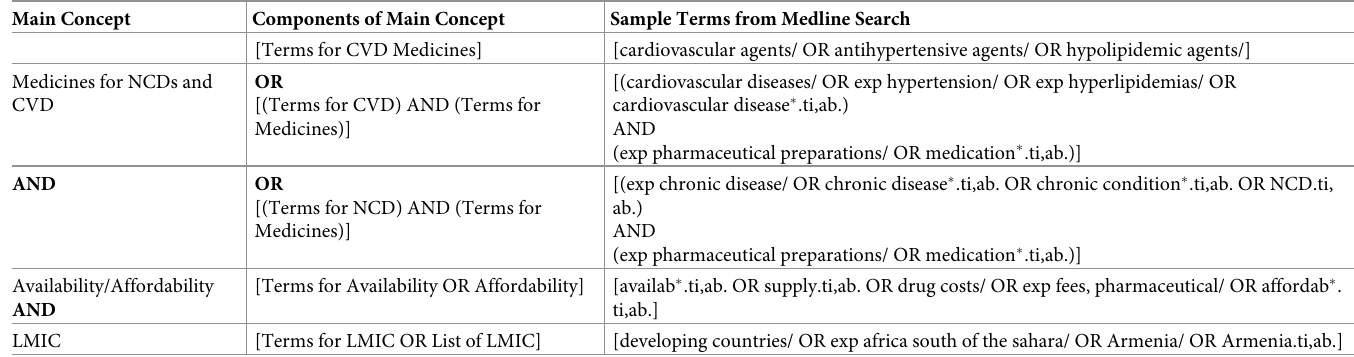
Table 1. Search strategy combining three themes: Medicines for NCDs and CVD, availability or affordability, and LMICs. Main